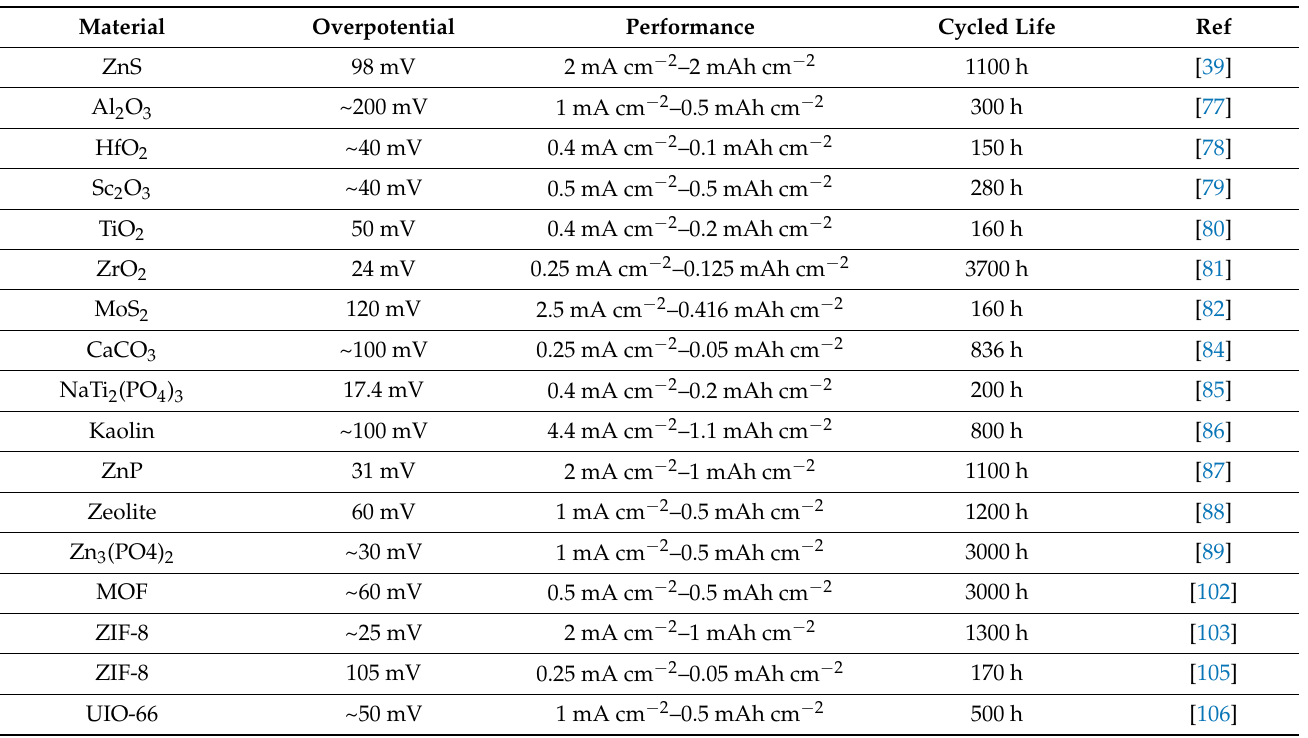
Table 3. Summary of metal oxides, metal sulfides, metal-organic frameworks (MOFs) and inorganic compounds coated on Zn